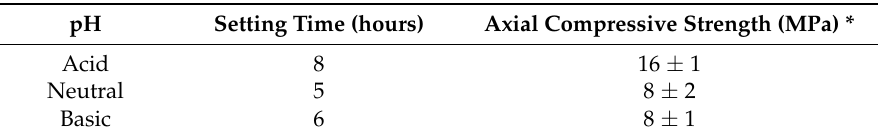
Table 5. Setting time and axial compressive strength in